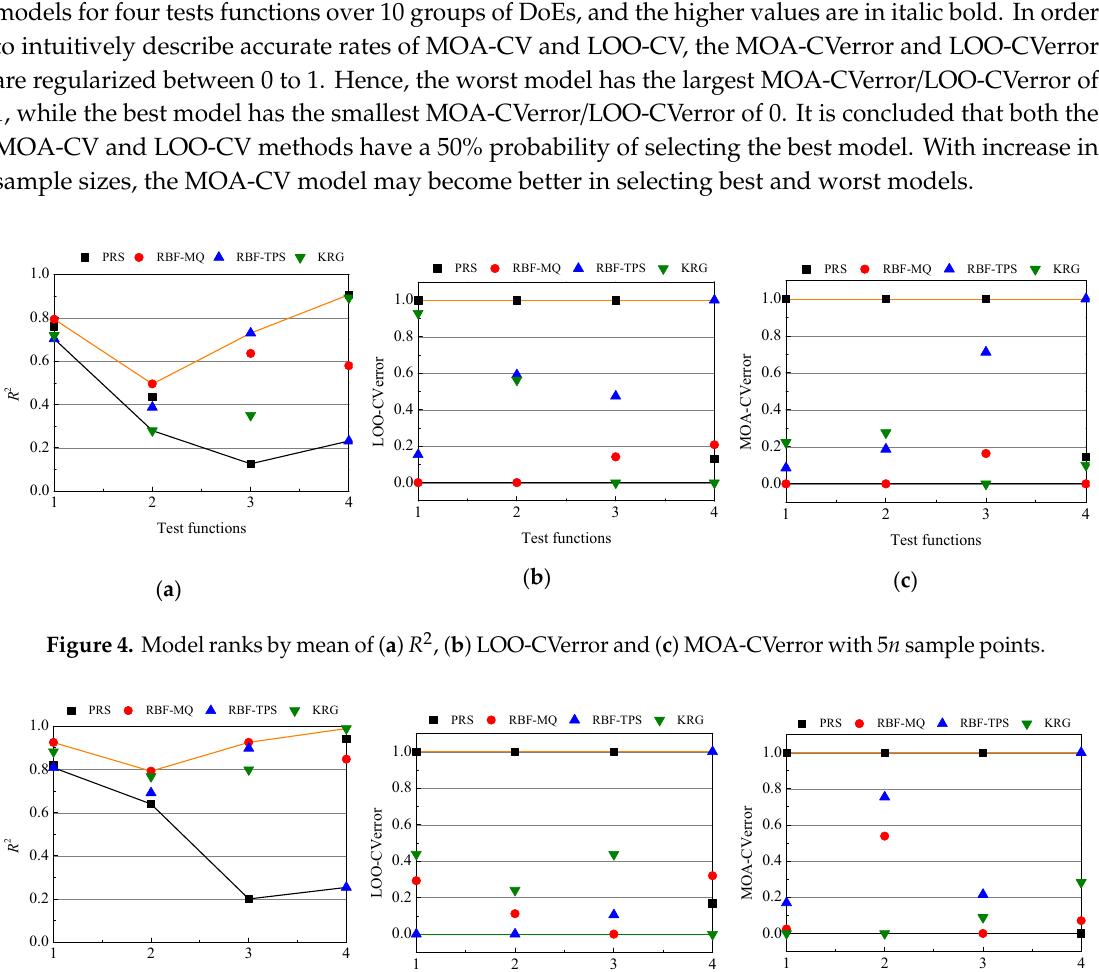
Figure 5. Model ranks by mean of ( a ) R 2 , ( b ) LOO-CVerror and ( c ) MOA-CVerror with 8 n sample points.